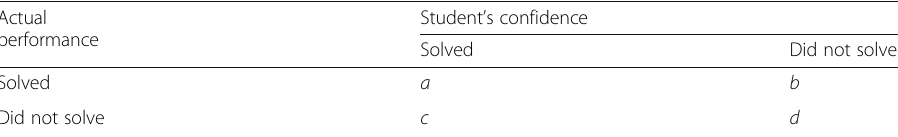
Table 2 Scores generated according to the KMA method Actual performance